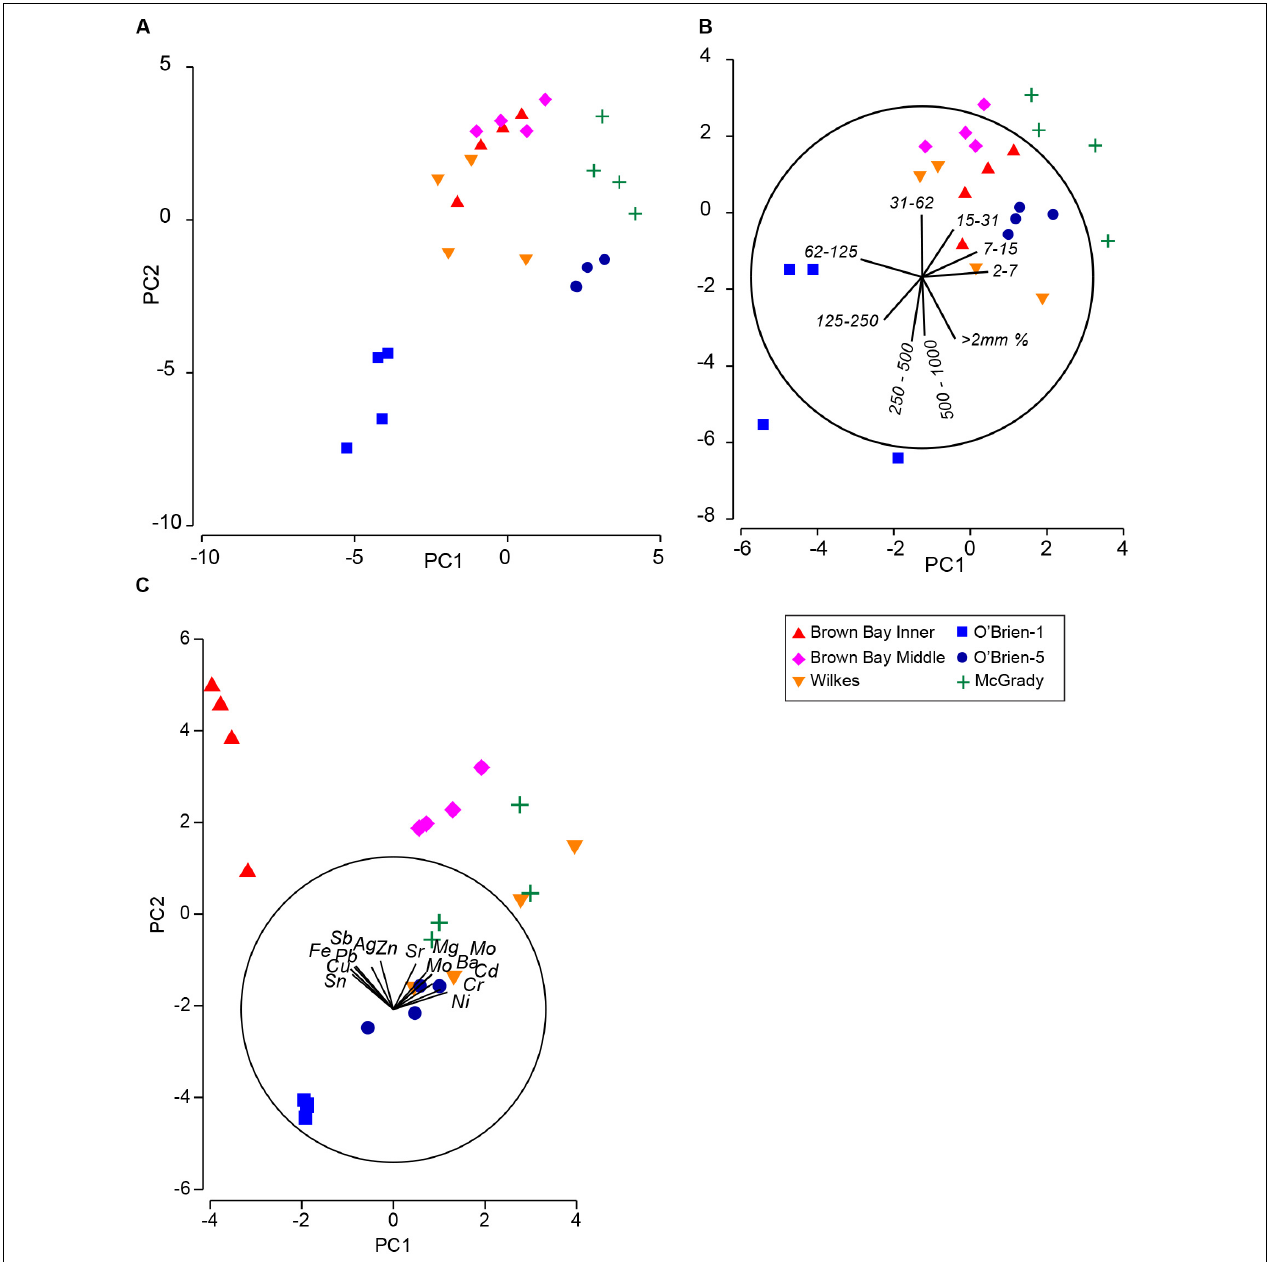
FIGURE 7 | (A) PCA ordination of combined environmental variables; (B) PCA ordination of sediment grain size variables; (C) PCA ordination of metal concentrations in sediment. Vector plots indicate the direction and size of the correlation between PC axes and variables.